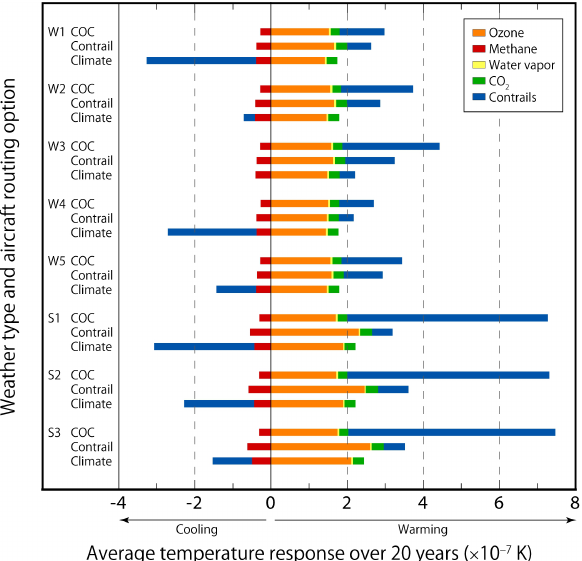
6 Figure 6. Changes in ATR20 components obtained from one-day air traffic simulations for the representative days of each weather type. For each type, three bars show the results for the COC, contrail and climate options. A bar consists of the values of ATR20 of ozone, methane, water vapor, CO 2 and contrails; those values are calculated by the aCCFs . The individually colored components of the bar are stacked according to their positive or negative temperature responses.